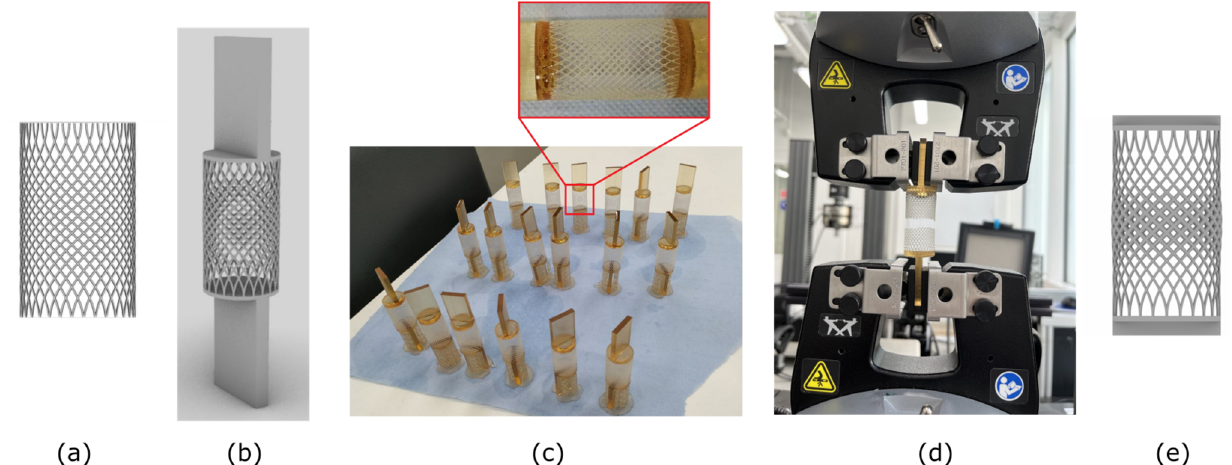
Figure 7. Manufacturing and testing of stent samples stages: ( a ) lattice design, ( b ) sample design, ( c ) printed parts: three samples for each of six modifications, ( d ) broken sample after mechanical tensile test and ( e ) proposed improved design with gradient lattice design.